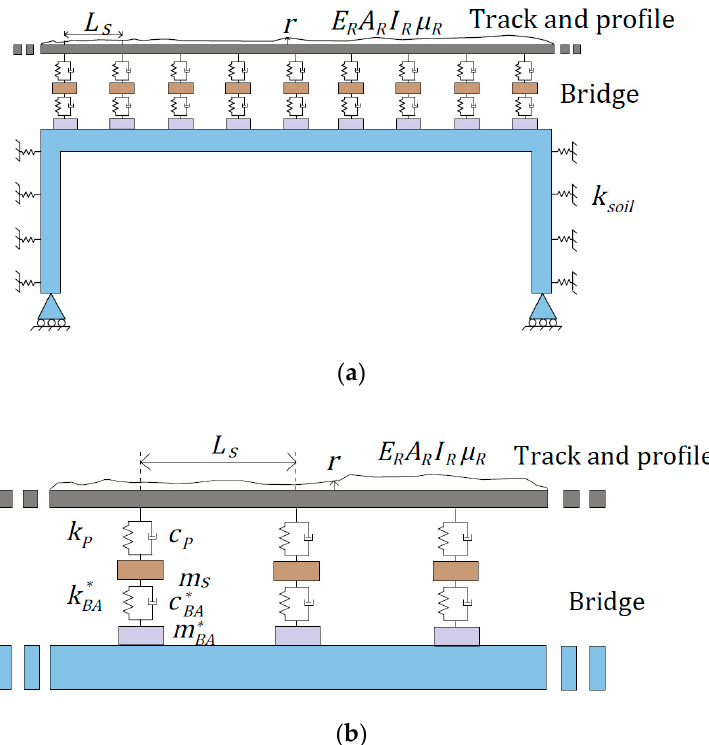
Figure 3. ( a ) Elevation of track-bridge model. ( b ) Detail of track-bridge model of ( a